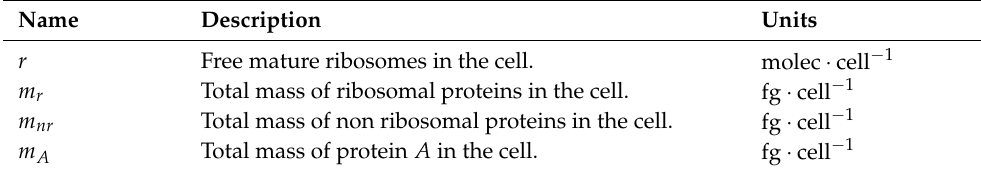
Table 1. States and main variables of the host